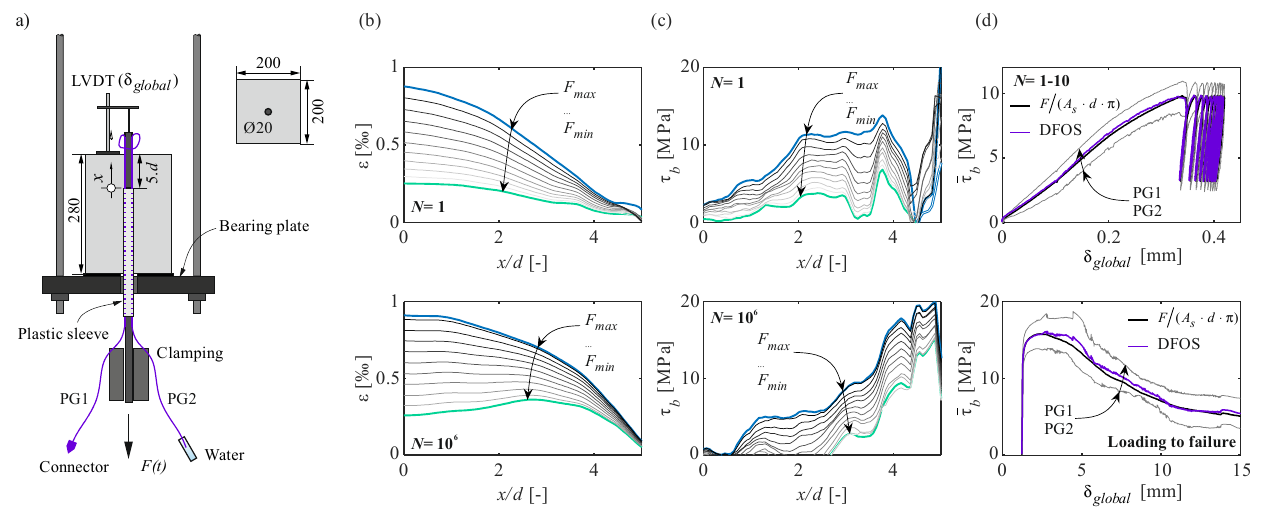
Figure 11. Pull-out test PO subjected to repeated tensile loading: ( a ) setup, geometry and instrumentation—dimensions in [mm]; ( b ) strain distribution along the bonded length for selected increasing load steps from F min to F max for first (top) and millionth (bottom) load cycle; ( c ) corresponding bond shear stress distribution and ( d ) comparison of the nominal bond shear stress and the mean value obtained from both fibre optical sensors PG1 and PG2 for the first ten load cycles (top) and the loading to failure after the millionth load cycle